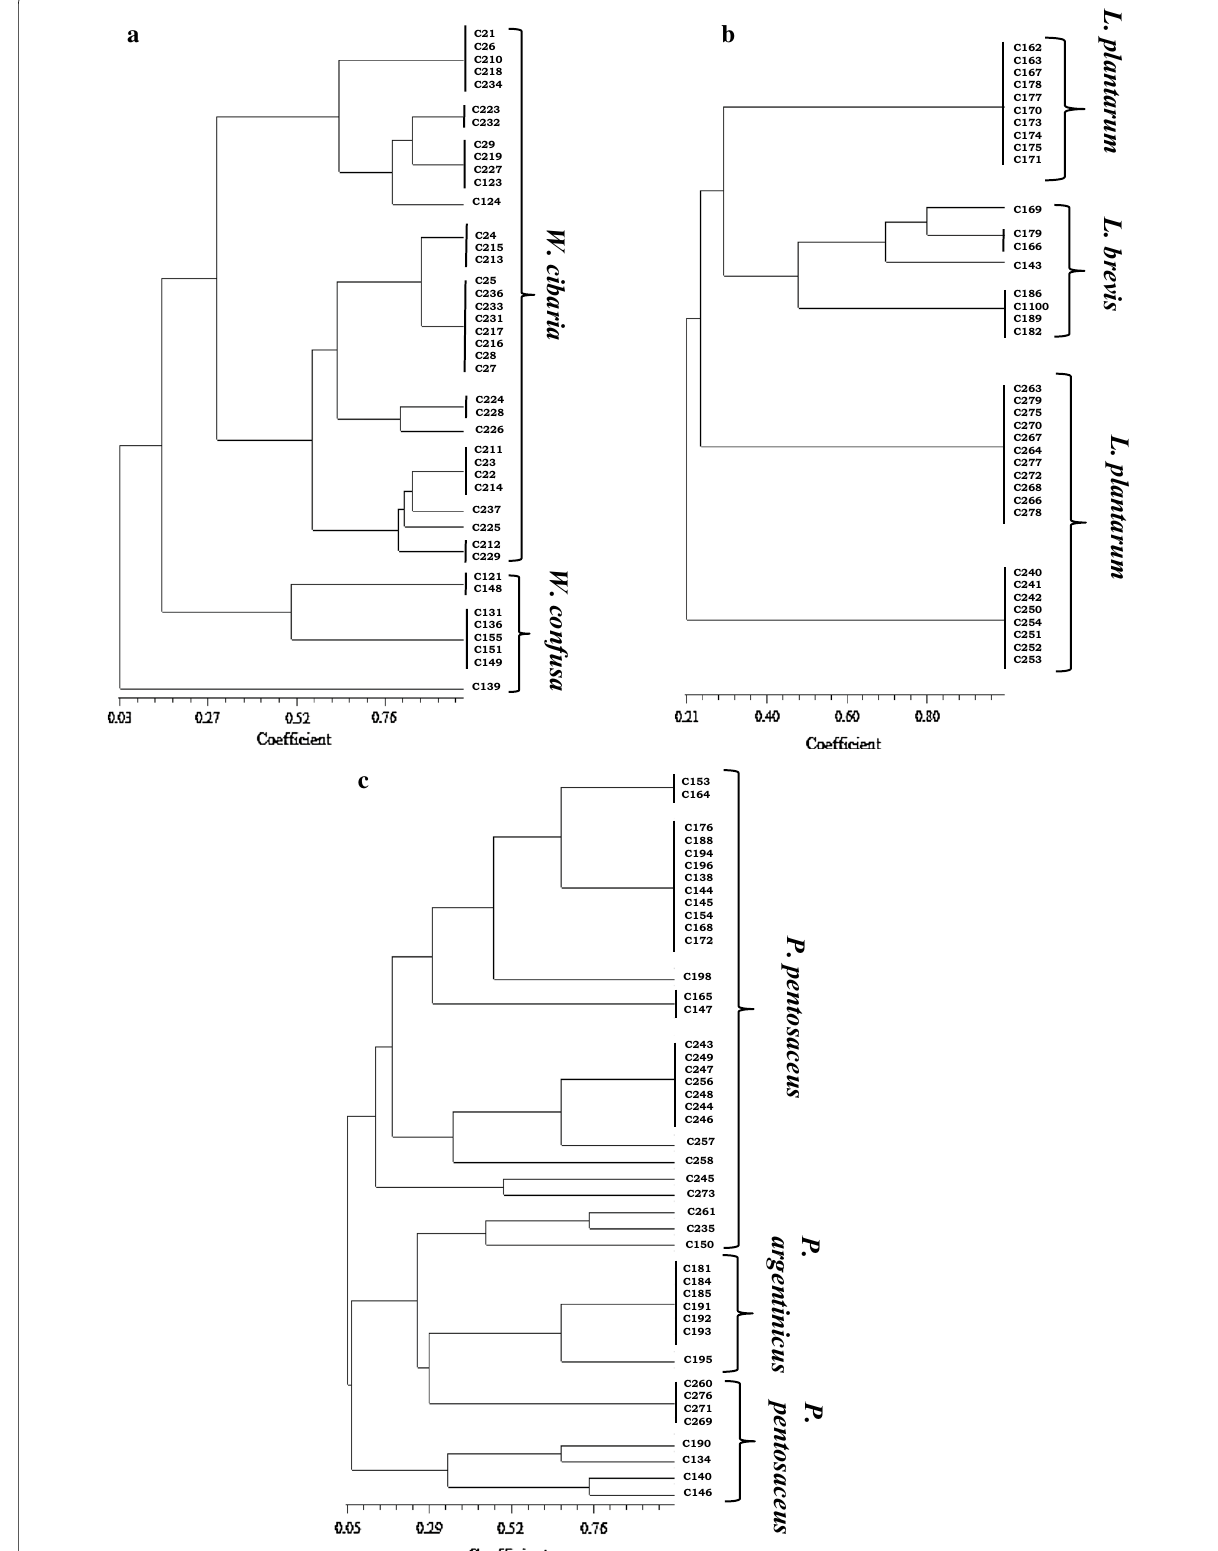
Fig. 2 RAPD-PCR profiles of LAB isolated during maize bran sourdoughs fermentation. Primers M13 ( a , b ) and LP1 ( c